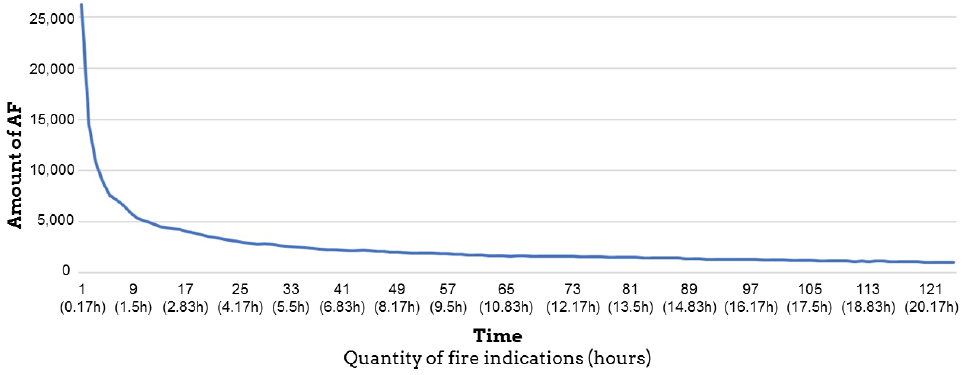
Figure 7. Number of active fires detected according to the number of consecutive AF indicated by the